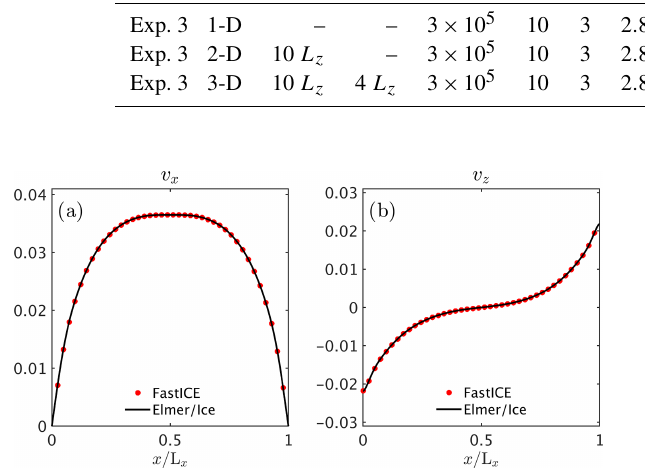
Table 2. Experiment 3: non-dimensional model parameters and the dimensional values (cid:0) D (cid:1) for comparison. Experiment L x L y L z